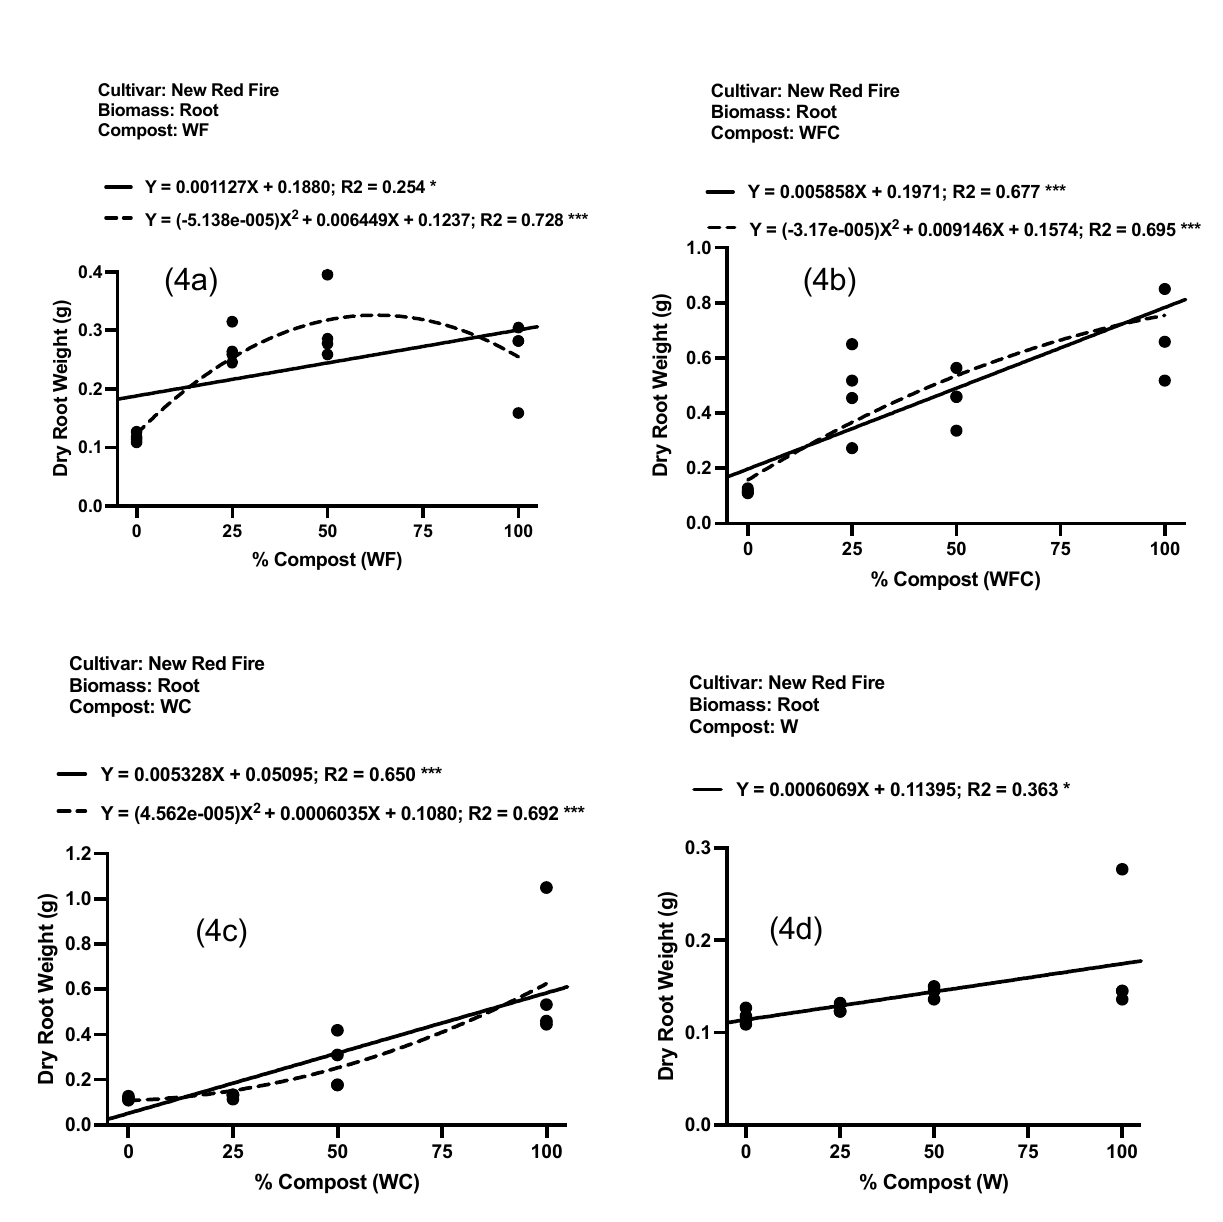
Figure 4. Effect of the percent of compost in growing media on the dry root biomass of cv. New Red Fire: ( 4a ) Compost WFC; ( 4b ) Compost WF; ( 4c ) Compost WC; and ( 4d ). * and *** significant at p < 0.05 and p < 0.001, respectively.